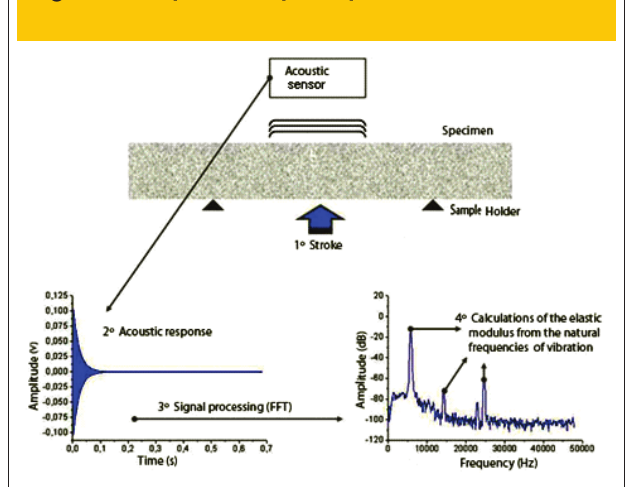
® Figure 1 – Operation principle of the